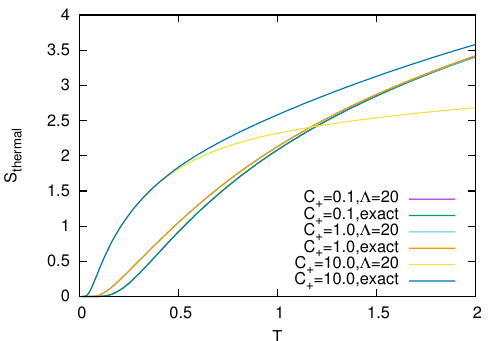
Figure 13 . Thermal entropy, analytic result vs numerical result, ω = 1 , with cutoff Λ = 20